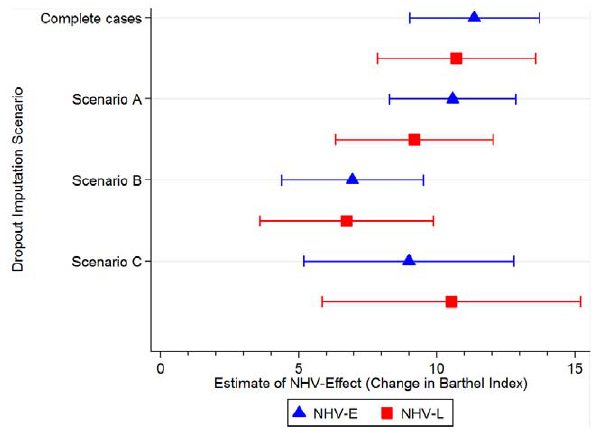
Figure 6. Sensitivity analysis: estimated change in NHV rehabilitation effect based on different dropout imputation scenarios. Legend: Scenario A = no dropouts incurred any change in Barthel Index; Scenario B = all dropouts decreased by ten points in Barthel Index at follow up; Scenario C = dropouts from the intervention groups did not change between baseline and follow up, while dropouts from the control group increased by ten points in Barthel Index; Complete cases = model estimation with valid cases only (see Table 2). Error bars represent 95% confidence intervals.